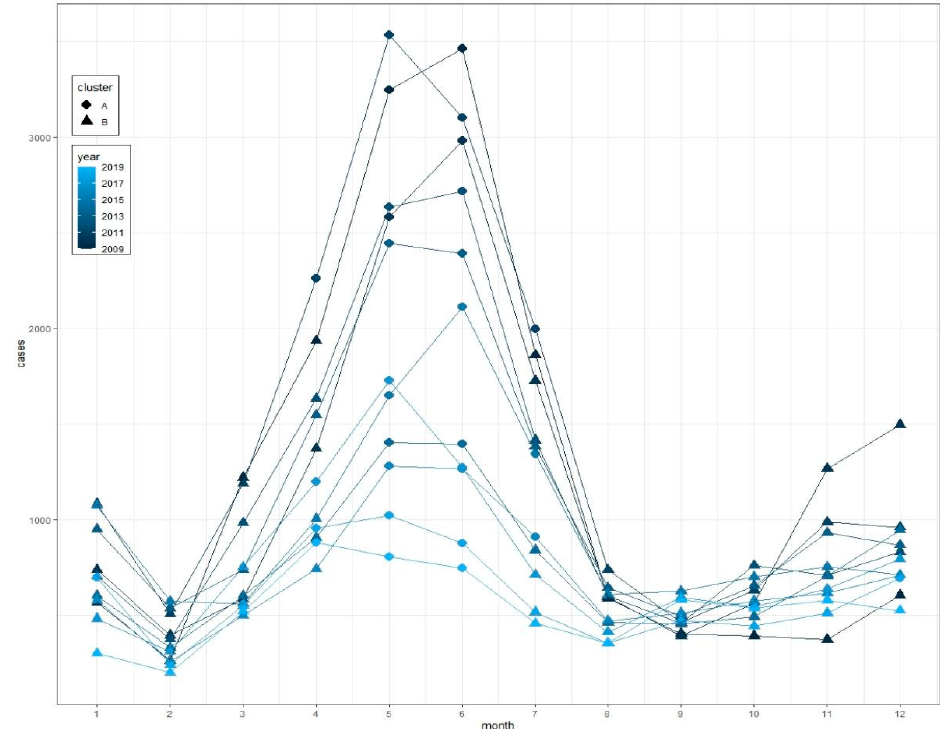
Figure 1. Monthly cases of mumps and clusters from 2009 to 2019 in Chongqing.